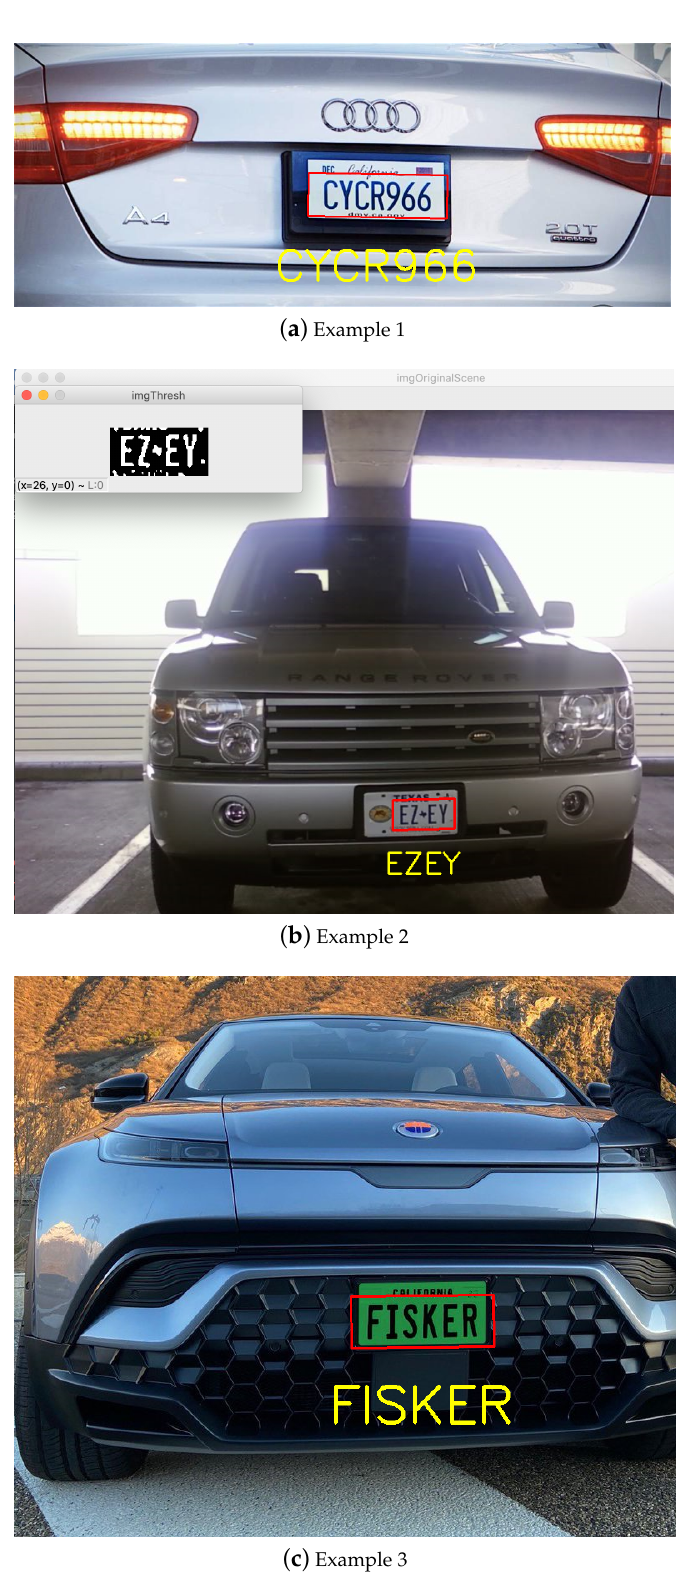
Figure 7. Examples of successful recognition of all plate